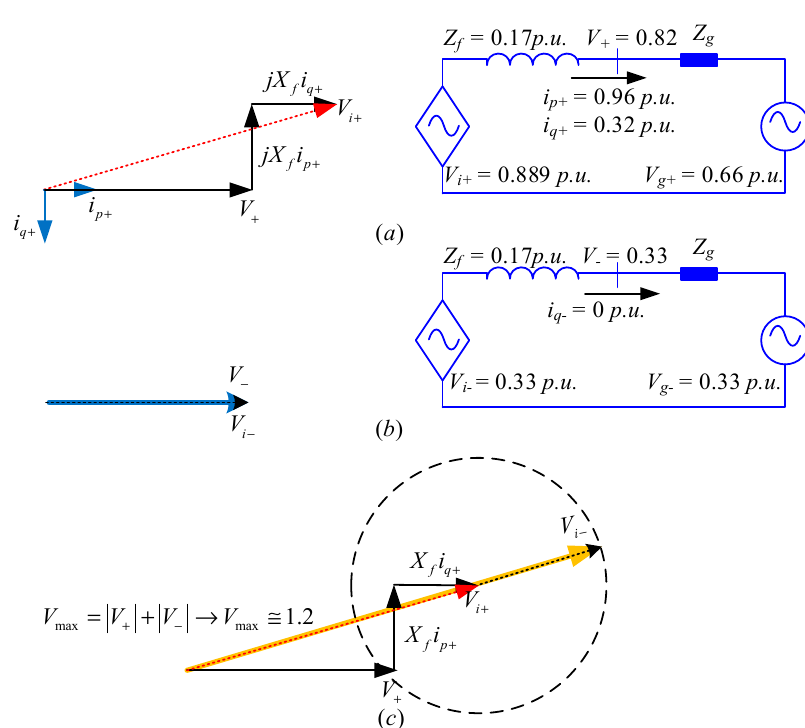
Figure 6. Vector representation of voltages and currents GC-VSC for unbalanced voltage sag without injecting negative sequence current during the fault. ( a ) Positive sequence. ( b ) Negative sequence. ( c ) Inverter voltage in the worst case.